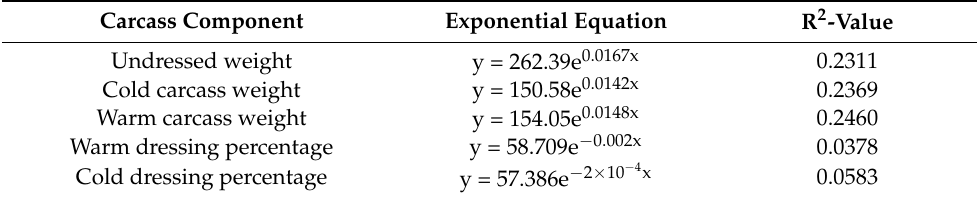
Table 2. The coefficient of determination (R 2 -value) and the exponential equation to indicate the relationship between the respective carcass parameters and age of Plains zebra stallions (aged between 2 and 13 years) harvested during a summer season in the Western Cape Province of South Africa. Carcass Component Exponential Equation R 2 -Value Undressed weight y = 262.39e 0.0167x 0.2311 y = 150.58e 0.0142x 0.2369 y = 154.05e 0.0148x 0.2460